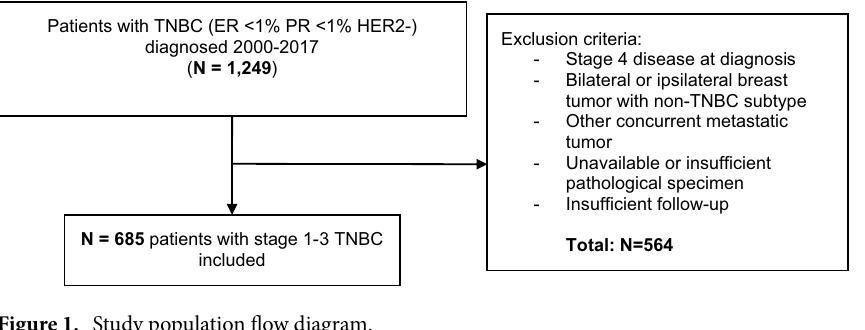
Figure 1. Study population flow